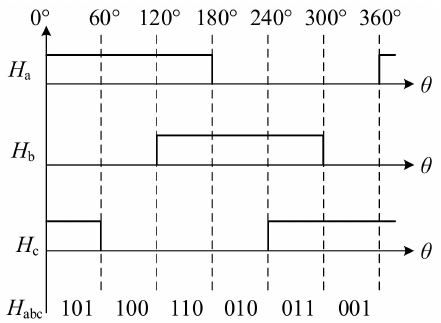
Figure 2. The waveforms of three Hall